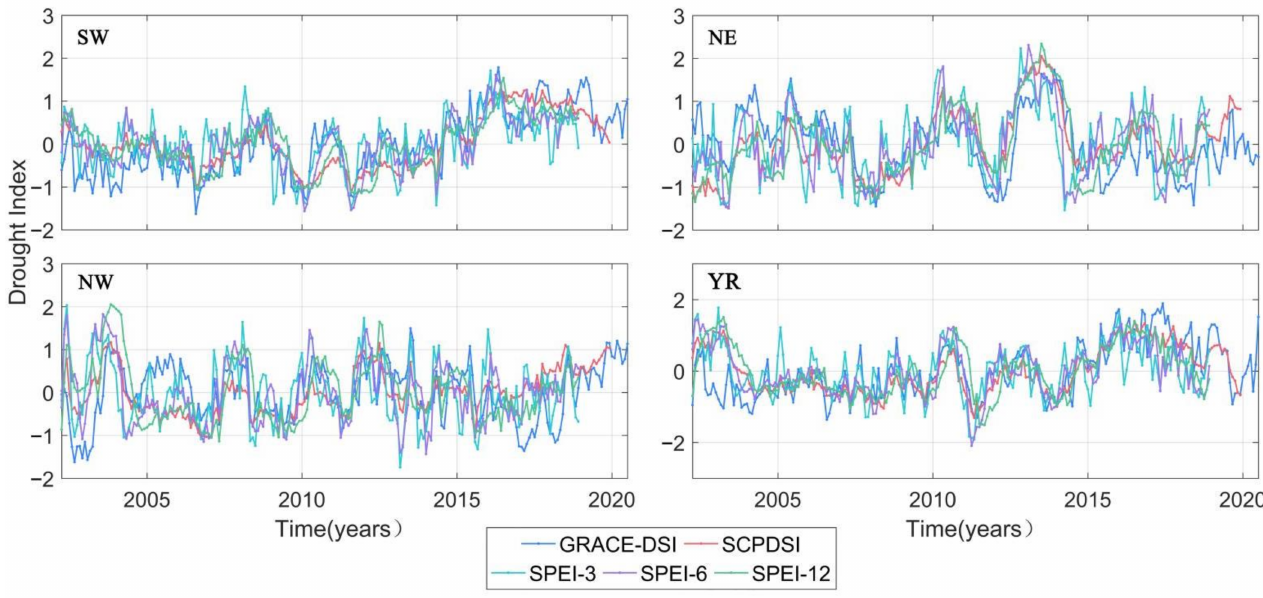
Figure 2. The time series of GRACE-DSI, SCPDSI, SPEI-3, SPEI-6, and SPEI-12 in MC during April 2002 and July